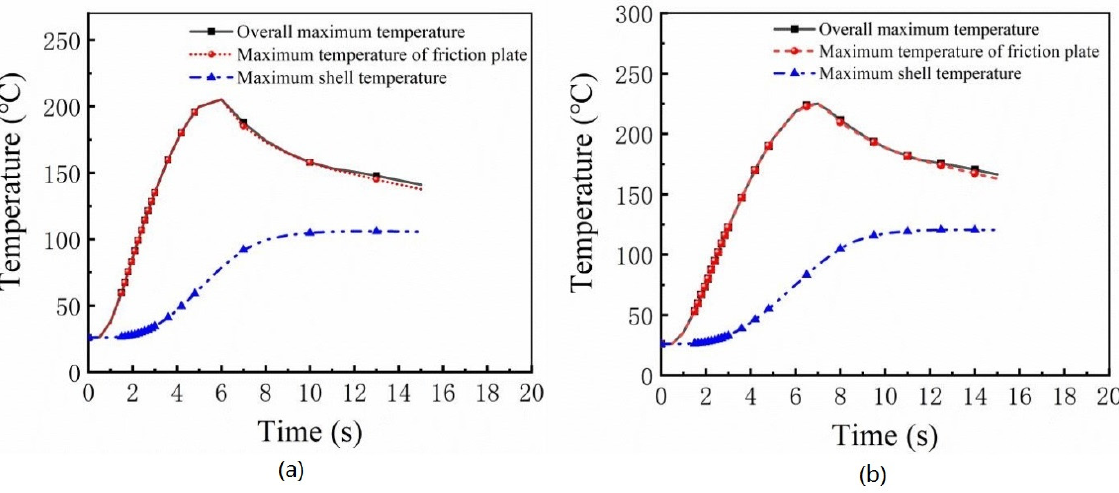
Figure 13. Temperature curve of conventional fixed slope. ( a ) Engagement pressure rise time is 8 s ( b ) Engagement pressure rise time of 10 s.